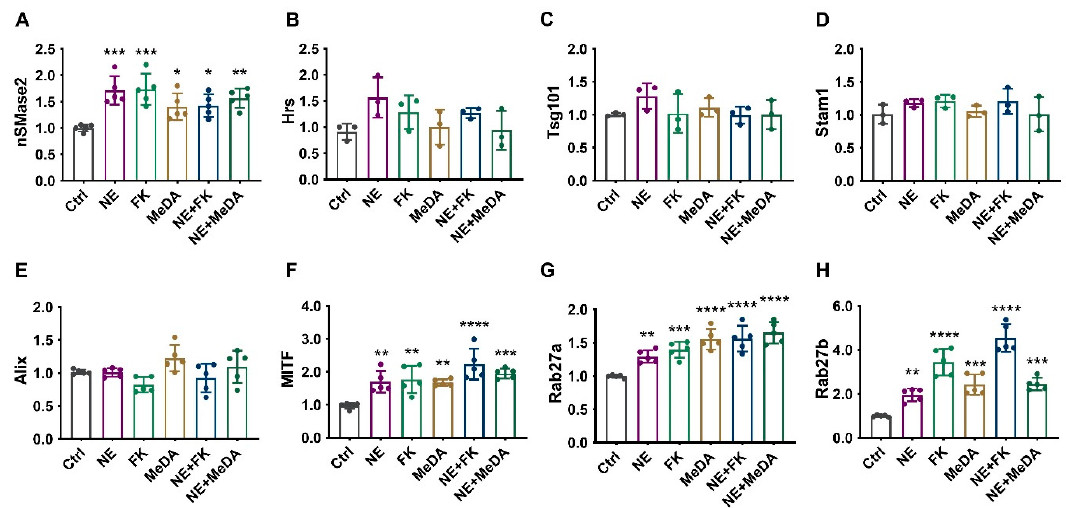
Figure 5. The effect of small molecule compounds on exosomal production-related pathways after 48 h treatment. RT-PCR quantification of ( A ) nSMase2 ( SMPD3 ), ( B ) Hrs , ( C ) Tsg101 , ( D ) Stam1 , ( E ) Alix , ( F ) microphthalmia-associated transcription factor ( MITF ), ( G ) Rab27a , and ( H ) Rab27b . One-way ANOVA with Dunnett’s multiple comparisons test, * p < 0.05, ** p < 0.01, *** p < 0.001, **** p < 0.0001; n =